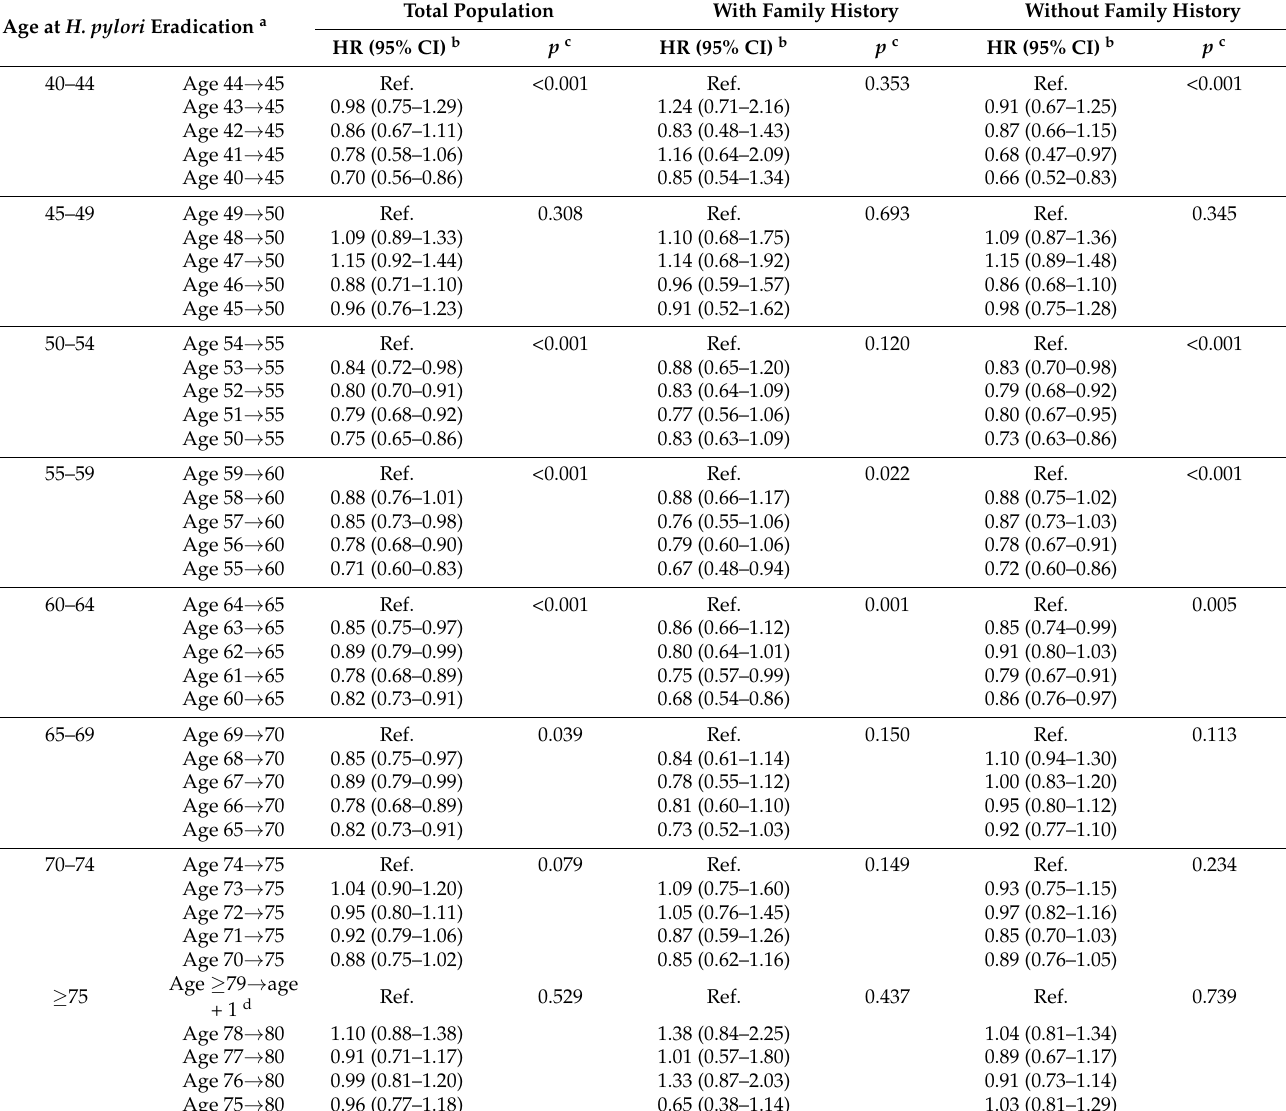
Table 6. Risk of gastric cancer according to age at H. pylori eradication by age